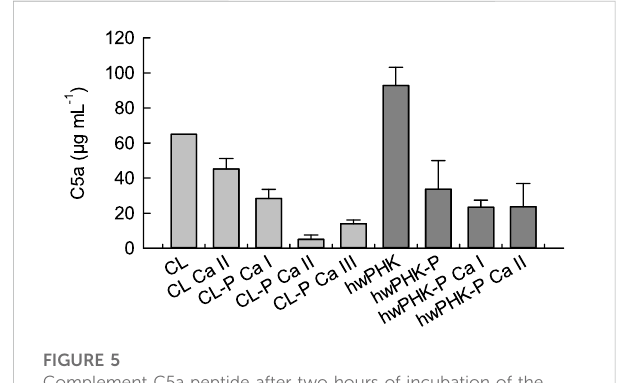
FIGURE 5 Complement C5a peptide after two hours of incubation of the cellulose samples with human whole blood.